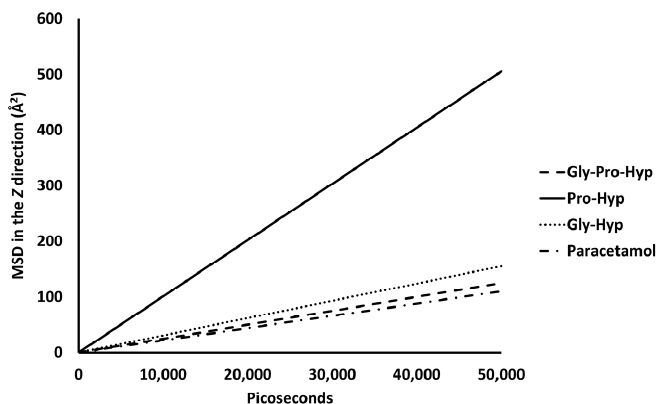
shown in linear fits in Figure 7.